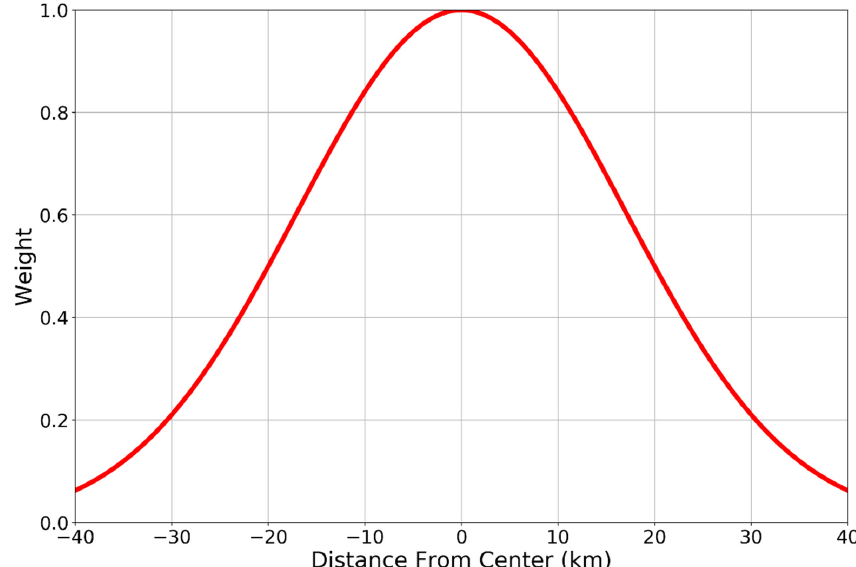
Figure 3. A graphical illustration of the Gaussian weighting method applied to each 0.25 × 0.25 degree grid point as described in Equation (1). The half-power footprint diameter was 40 km.